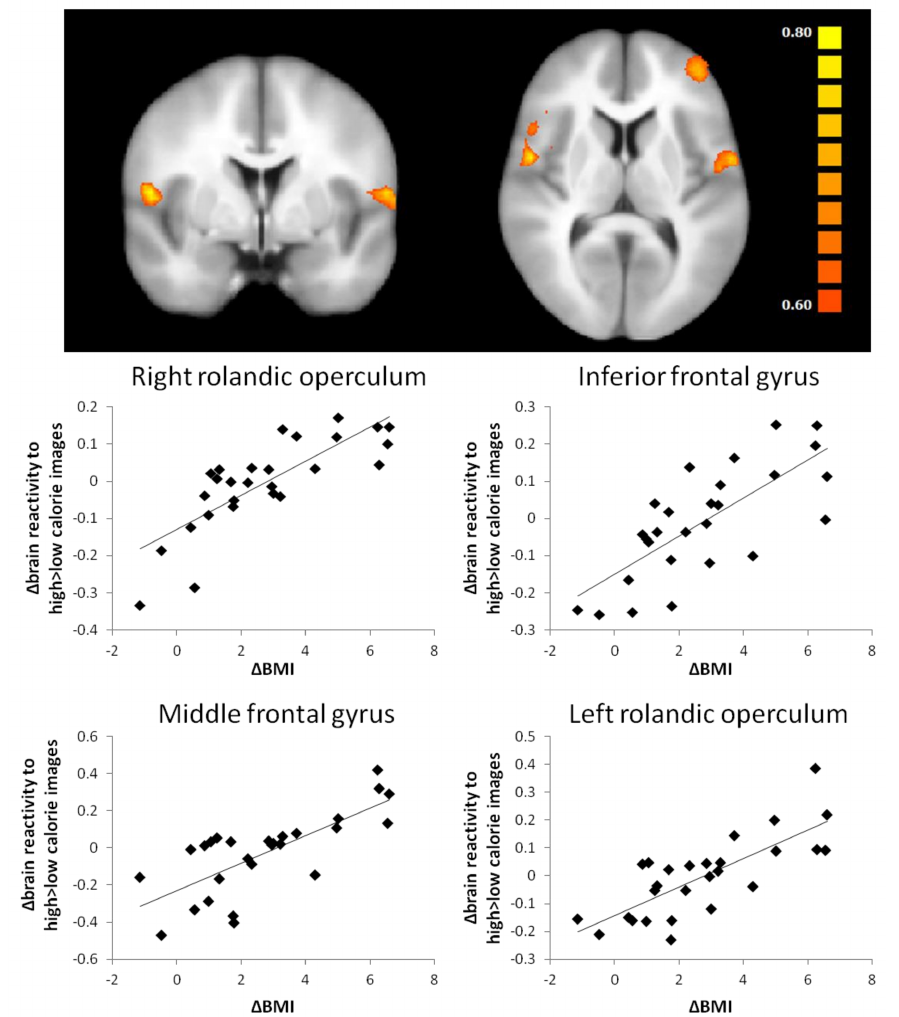
Figure 1. Whole brain contrast map of brain regions with significant associations between changes in high > low calorie images brain activation and changes in BMI. Positive associations are shown in orange ( p < 0.005, corrected for multiple comparisons). Scatter plots of changes in BMI and changes in extracted high > low calorie images BOLD response are shown